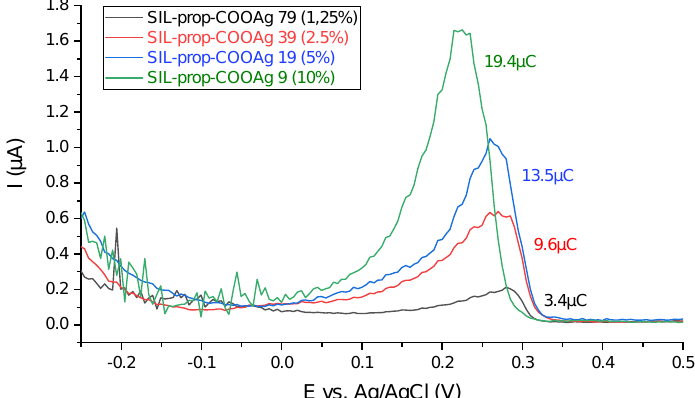
Figure 6. Differential pulse anodic stripping voltammetry (DPASV) curves recorded after 1 min electrolysis at − 0.25 V in 0.1 M NaNO 3 electrolyte solution using silver-functionalized samples deposited on FTO-covered glass: vertically aligned porous silica thin films containing various contents of silver ions anchored via propyl-carbonate units. Conditions of experiment: pulse height of 2.5 mV, pulse width of 100 ms, step height of 5 mV and step time of 500 ms.